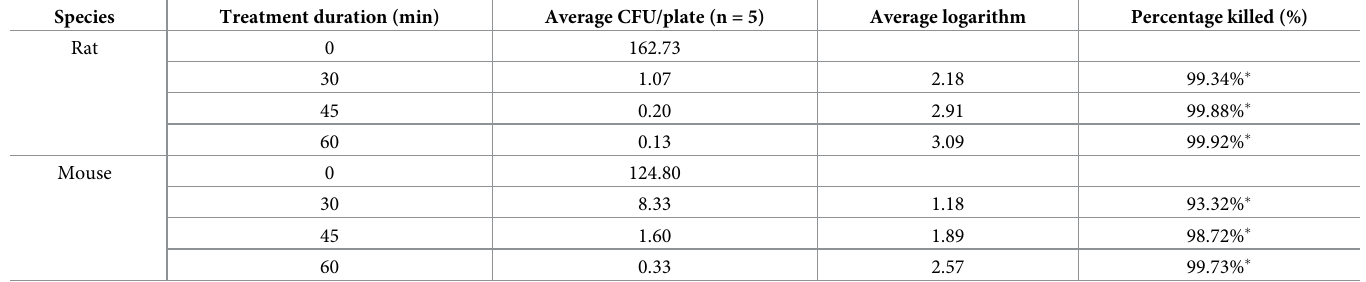
Table 1. The effectiveness of ozone treatment on soiled bedding of rats and mice. Species